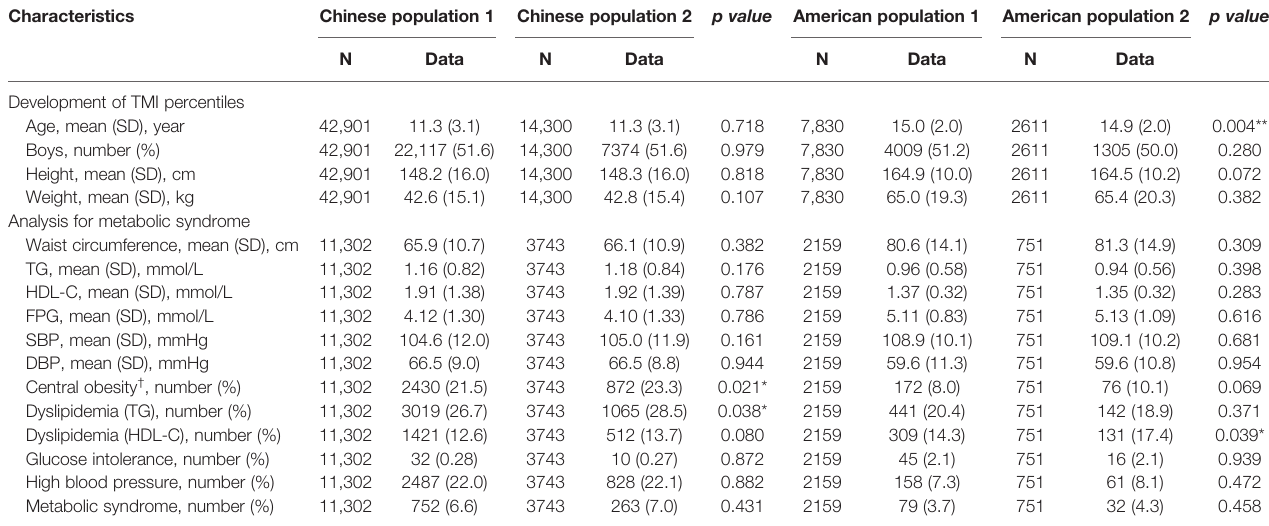
TABLE 1 | Characteristics of Chinese and American participants, with mean and standard deviation (SD) for continuous variable and number and % for categorical variables.